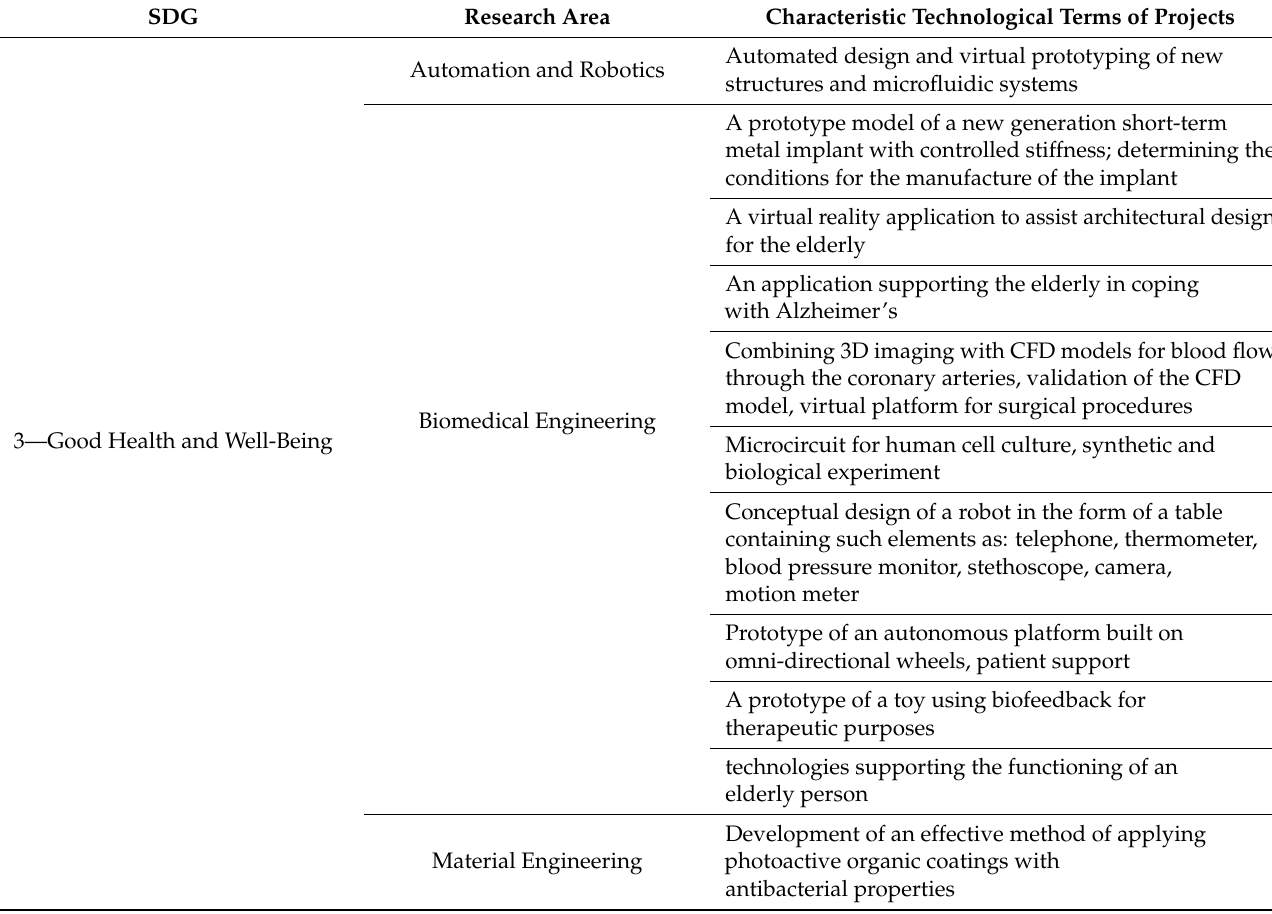
Table 8. Characteristic technological terms of projects for Good Health and Well-Being. SDG